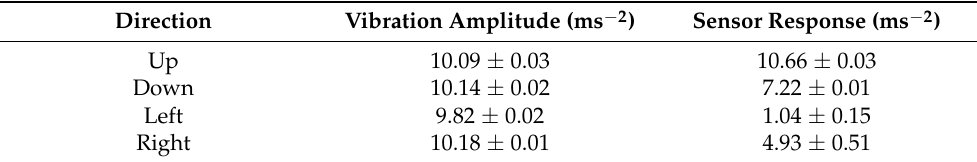
Table A1. Sensor response when attached to the vibration stage at different positions.